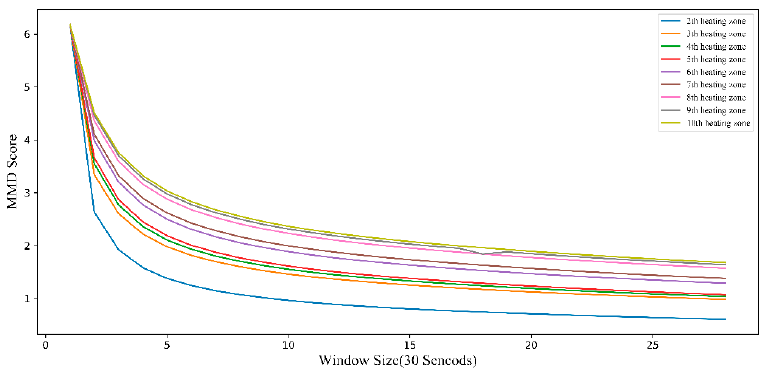
Figure 8. Maximum mean discrepancy (MMD) scores of source domain and target domain under different sliding window sizes. This score represents the similarity measurement between the rest of the zones and zone 1. The figure in the upper right corner refers to the MMD scores of zone 2 and zone 1, and the MMD scores of zone 3 and zone 1, all the way to zone 10.